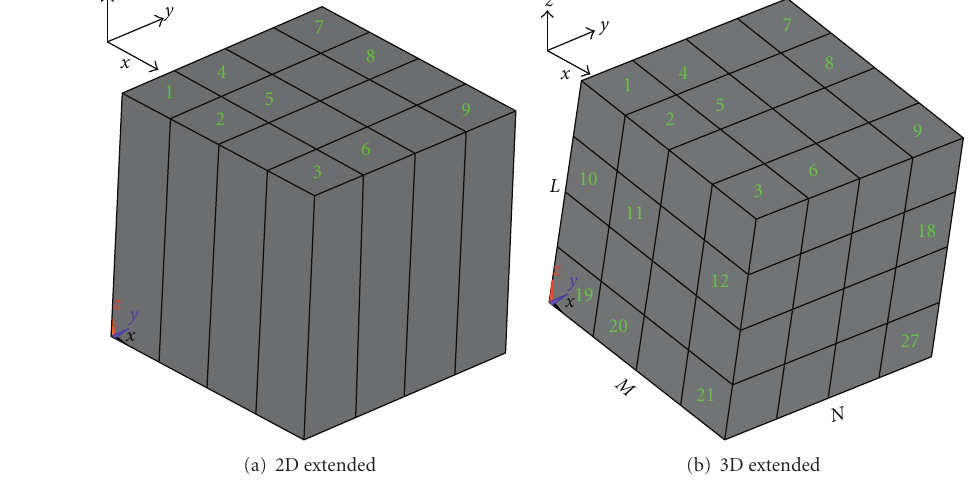
Figure 2: Domain decomposition style of a brick domain.